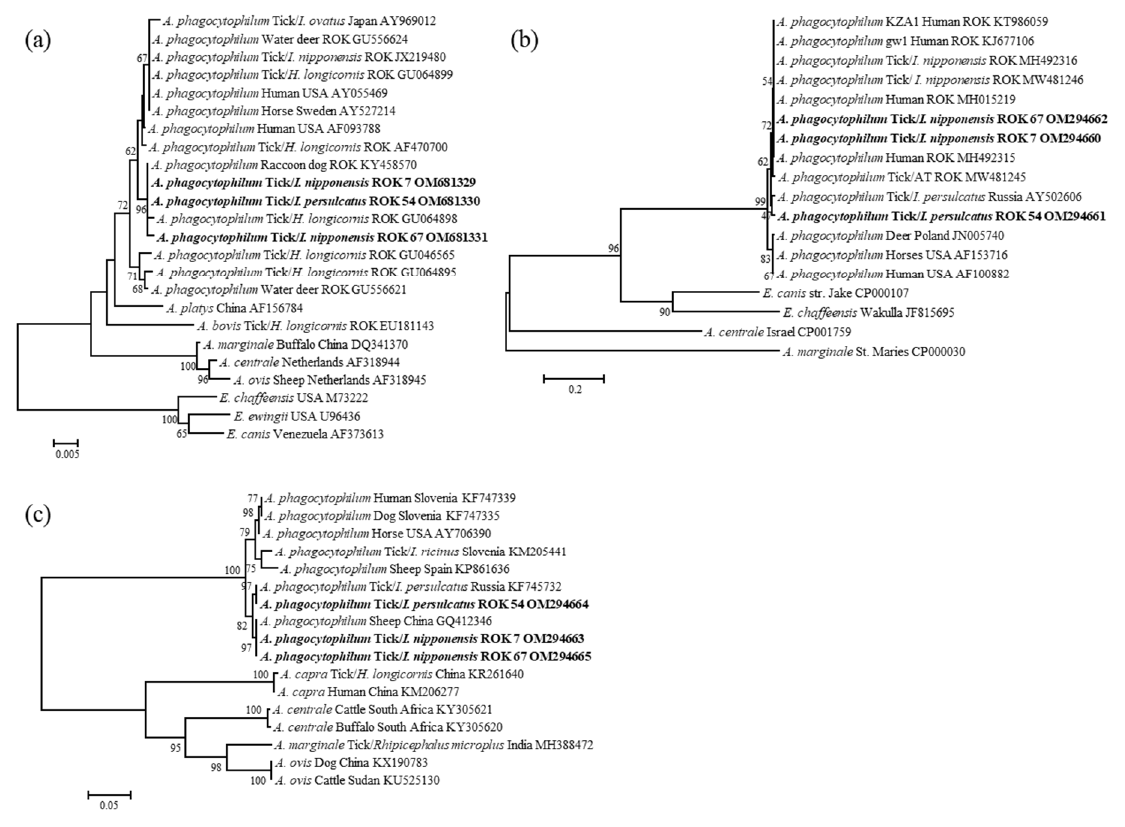
Figure 1. Phylogenetic relationships for Anaplasma phagocytophilum , based on the partial nucleotide sequence of ( a ) Anaplasma 16S rRNA, ( b ) ank A, and ( c ) msp 4 gene. The neighbor-joining method was used for constructing a phylogenetic tree. The numbers at the nodes represent the proportion of bootstrap values for the branch point. The three A. phagocytophilum -positive sequences identified in this study are indicated in bold. Reference strains of Anaplasma with the host, country of detection, and the National Center for Biotechnology Information accession numbers are also shown. Scale bars indicate sequence distances.